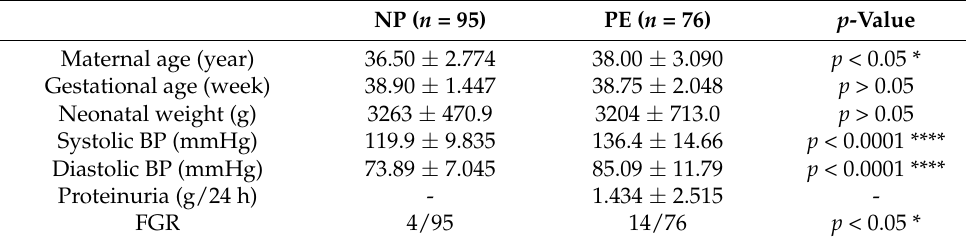
Table 1. Clinical characteristics of the study